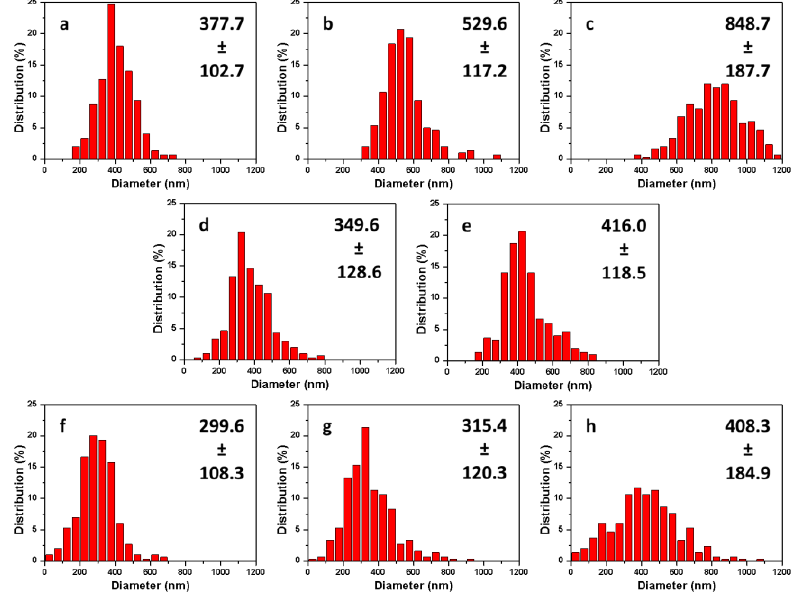
Figure 4. Diameter histograms of fibers produced from pure PEO ( a : 3%; b : 4%; c :5%), blended PEO-PANI ( d : 3%–2.5%; e : 4%–2.5%), and side-by-side PEO- PANI ( f : 3%–2.5%; g : 4%–2.5%; h : 5%–2.5%). The insert data was fiber average diameter and standard deviation in nm.